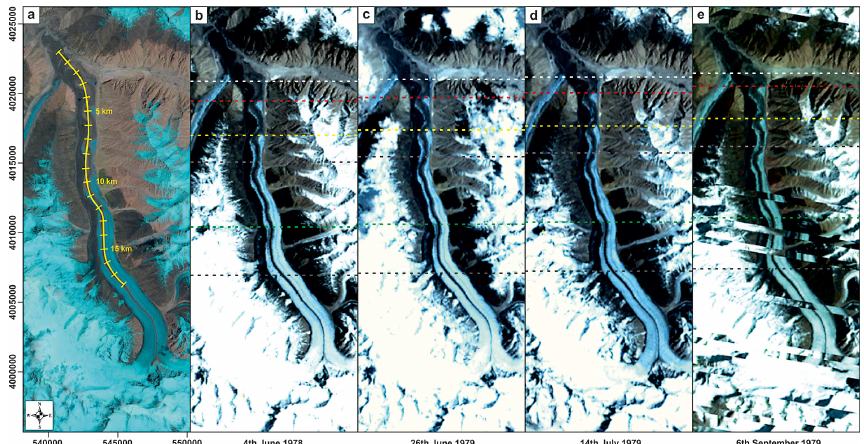
Fig. 1. (a) The Khurdopin Glacier imaged on 6 July 2013 by the Landsat Operational Land Imager, overlaid with centreline from which the data in Fig. 2 were extracted. (b–e) The surge of 1979 evidenced in multi-temporal Landsat MSS data. Dashed lines correlate with distinct features that can be tracked moving down-glacier (north) in each subsequent image. Note that the surge has minimal impact beyond 15km from the